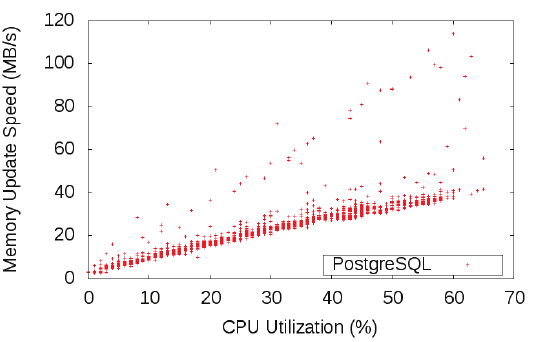
Figure 6 . The degree of correlation between the "CPU Utilization" and the "Memory Update Speed" [3].